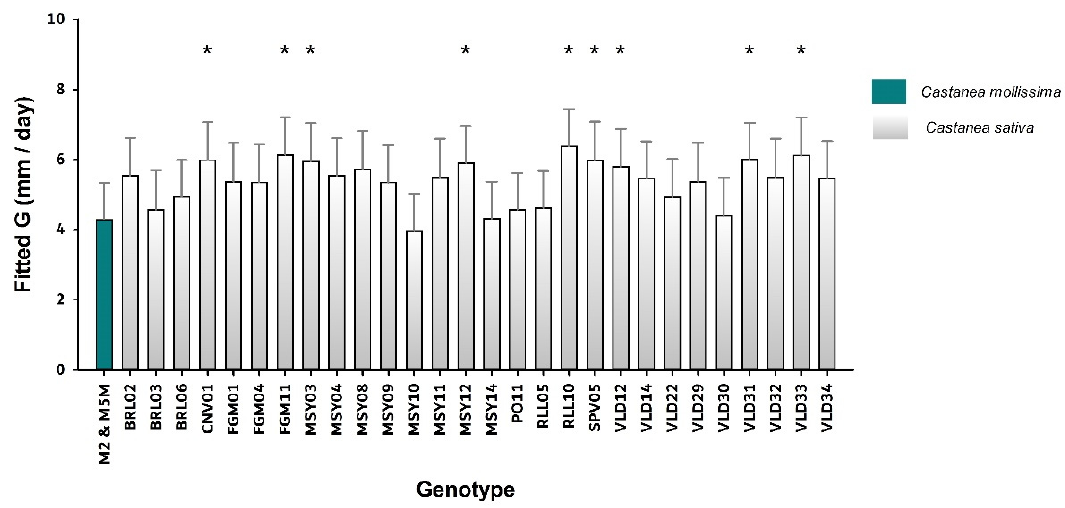
Figure 2. Values of mean daily lesion growth rate (G) of Cryphonectria parasitica on cuttings of Castanea sativa genotypes fitted by model Ma1 (Assay A). Mean values and 95% confidence error are shown. Asterisk (*) denotes significant differences in respect to Castanea mollissima (average value of “M2” and “M5M”). Number of repetitions: 8 (“M2” and “M5M”); 8 (all genotypes of C. sativa ).